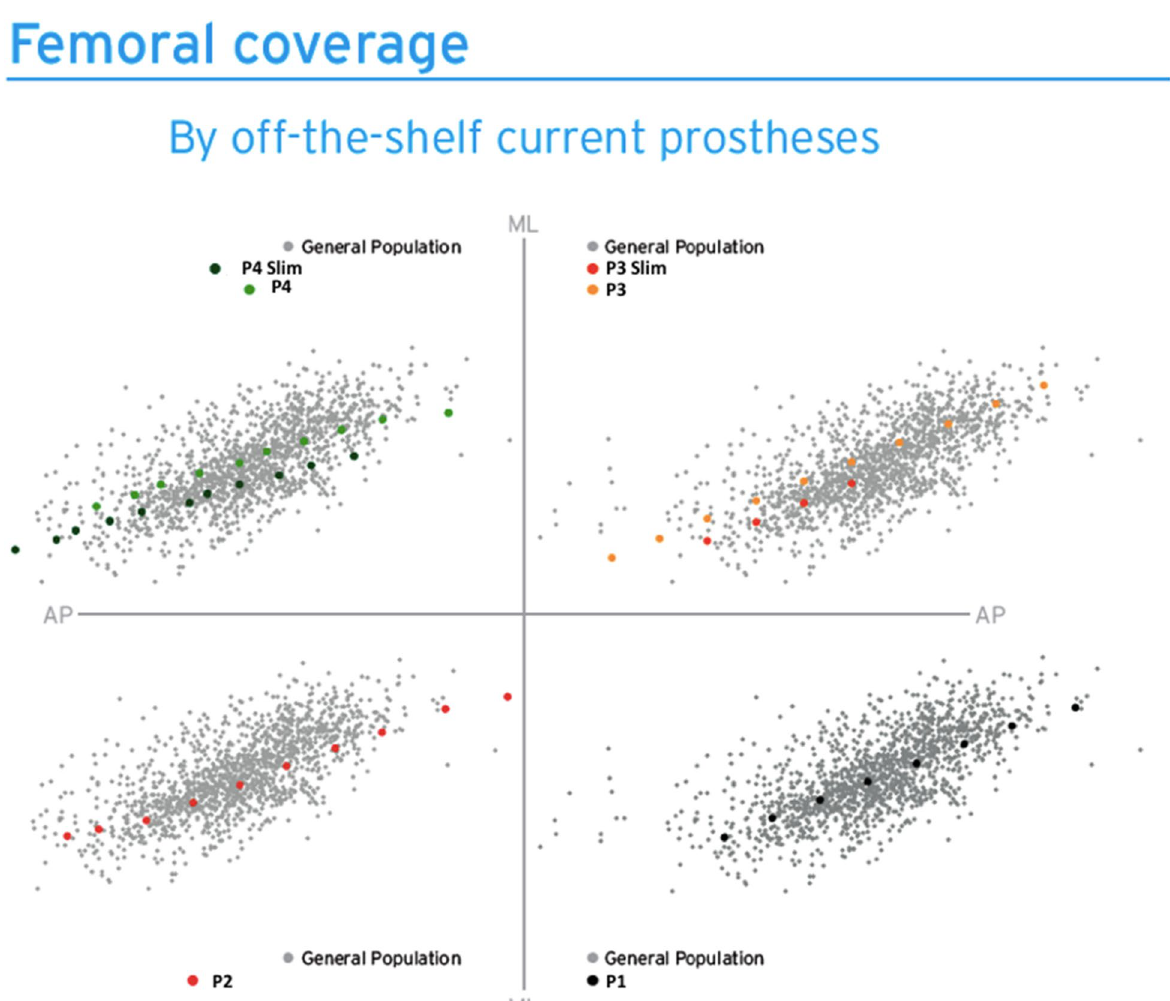
Fig. 5 Coverage offered by off the shelf traditional femoral prostheses (P1, P2, P3, P4 and the Slim version of P3 and P4). Each grey dot depicts an individual femur in the database and each colored dot a femoral implant size. Legend: ML medio-lateral, AP: